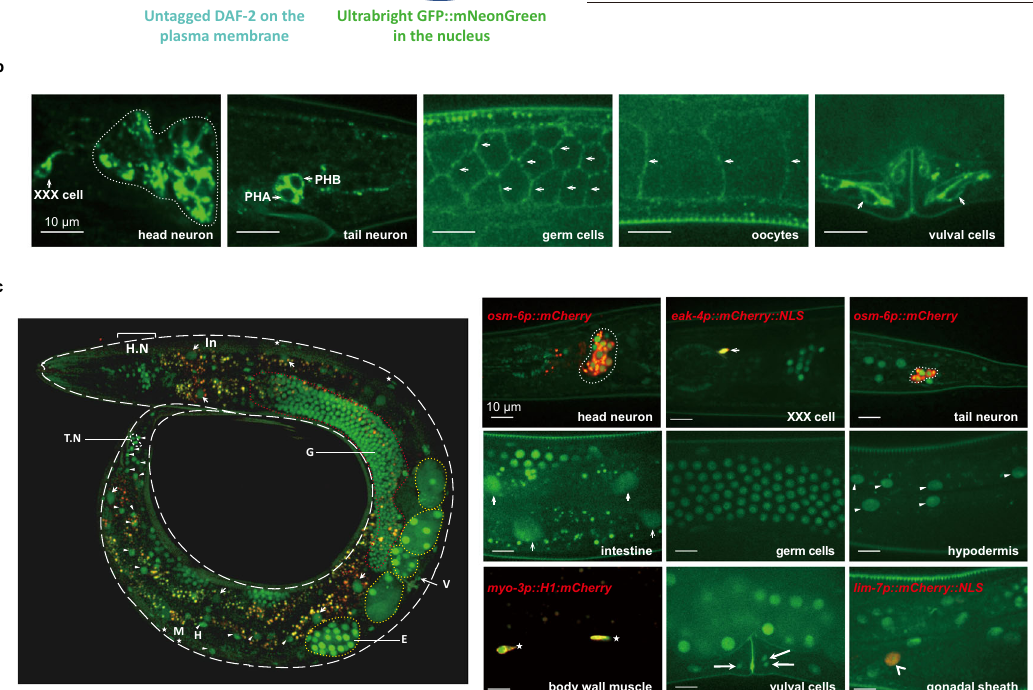
the expression of daf-2 mRNA throughout the whole body. H.N, head neuron; G, germ line, indicated by the circled red dotted line; In, intestine, indicated by short arrows; V, vulval cells, indicated by long arrow; E, embryo, indicated by the circled gray dashed line; H, hypodermal cells, indicated by triangles; T.N, tail neuron, indicated by the circled white dotted line; M, body wall muscle, indicated by asterisks. Right panel, local expression patterns of daf-2 mRNA. osm-6p::mCherry , ciliated sensory neuron marker; eak-4p::mCherry::NLS EGL-13 , XXX-cell-speci fi c mar- ker; myo-3p::H1::mCherry , body-wall-muscle-speci fi c marker; lim-7p::mCherry::NL- S EGL-13 , gonadal- sheath-speci fi c marker. A similar pattern of expression was observed in two independent experiments. d Summary of the spatiotemporal expression pattern of NuGFP reporter. +, expression intensity of NuGFP; -, expression of NuGFP is not